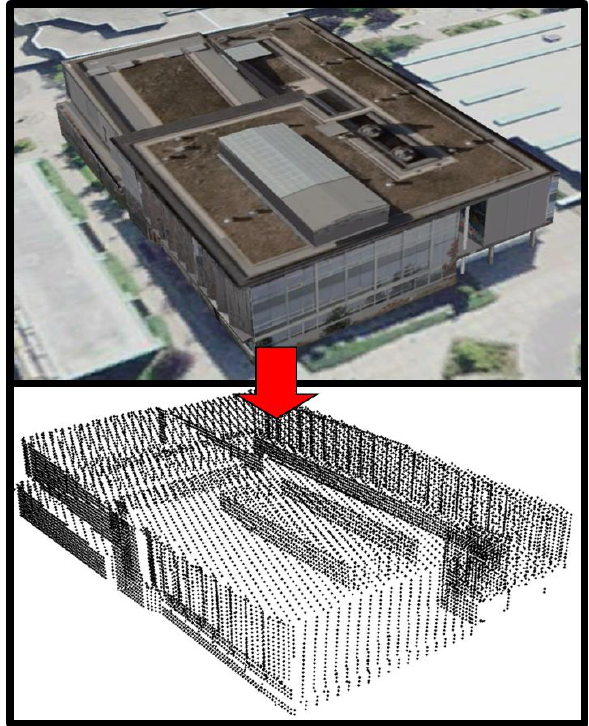
Figure 3: Converting 3D polygon building models to 3D point clouds: The Lassonde Building.